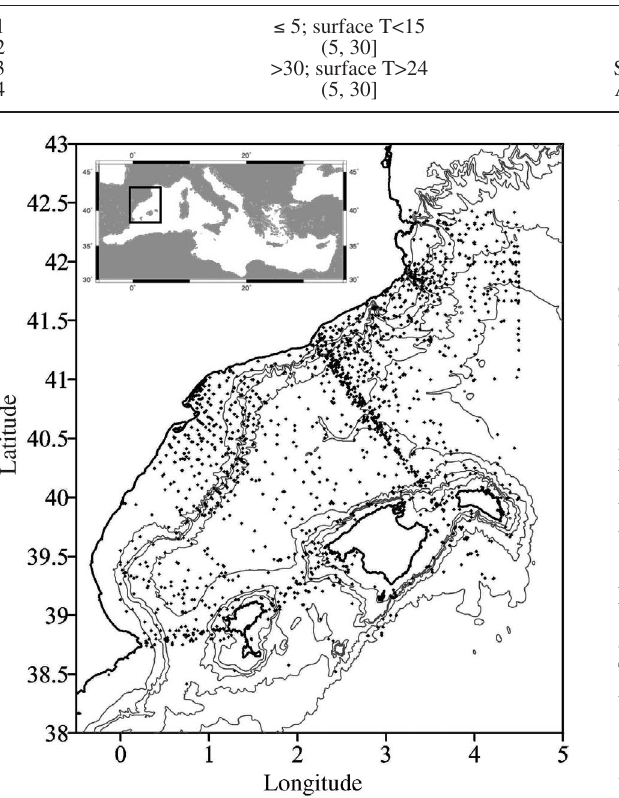
Fig . 1. – Map of the Catalan Sea with the position of the oceano- of the oceano- graphic stations sampled during the cruises collected for this study. The inlet map shows the position of the Catalan Sea in the Mediter- ranean